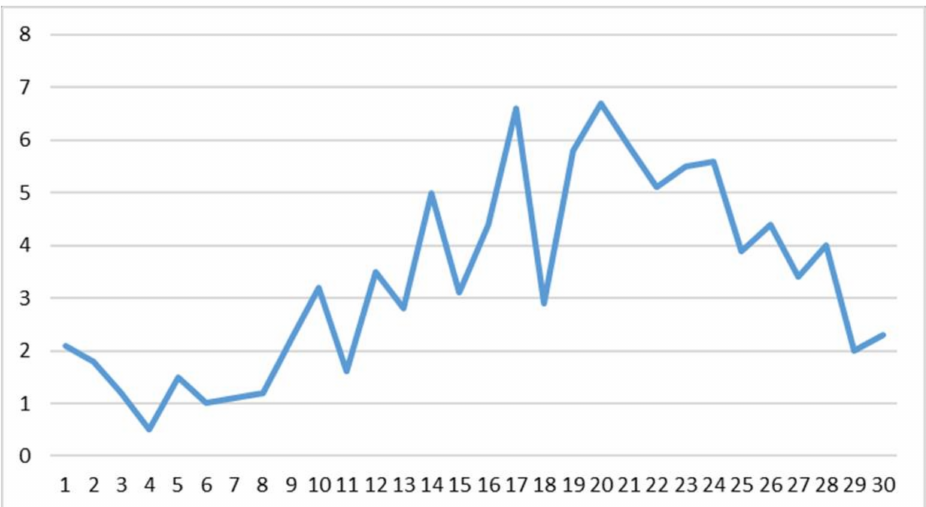
Figure 1. Father–adolescent relationship (v1 father) aggregate